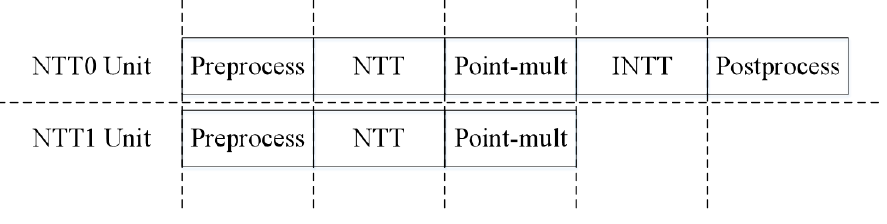
Figure 8. Polynomial multiplier operation flow.